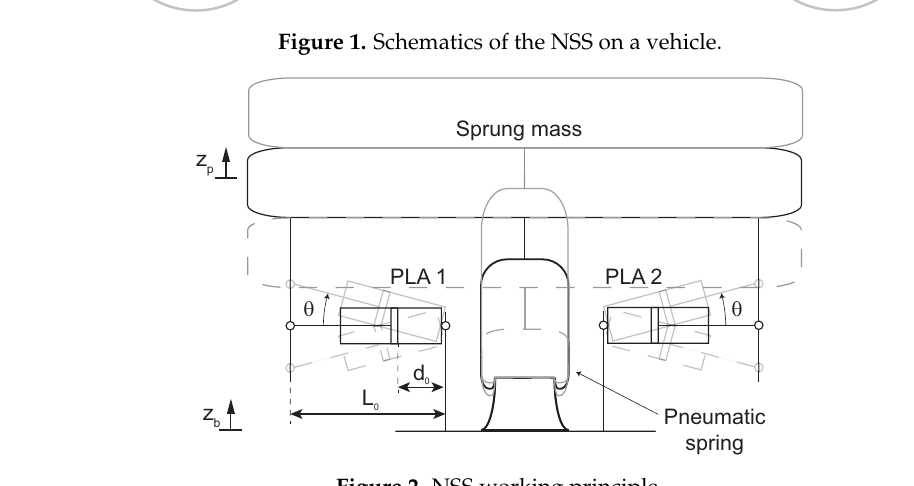
Figure 2. NSS working